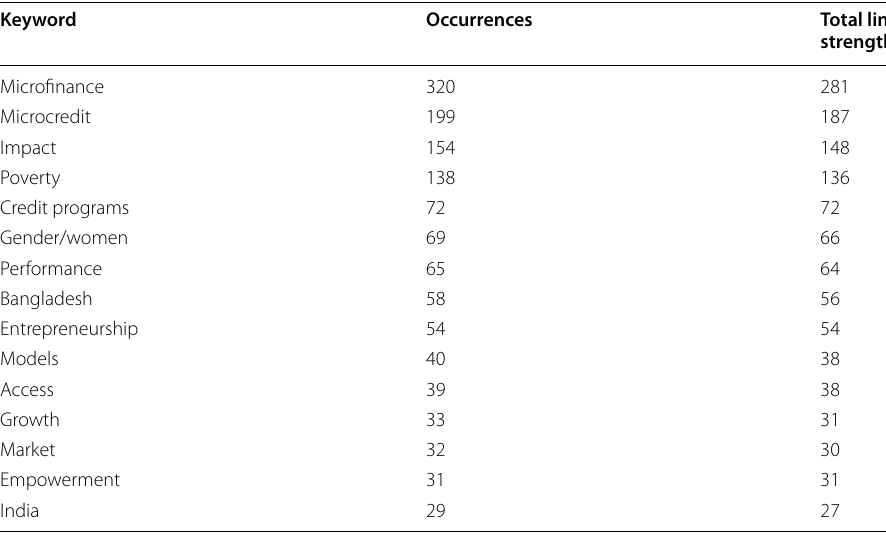
Table 8 Top 15 keywords occurrence based on 524 articles selected by the study methods using fractional counting method between 1:2012 and